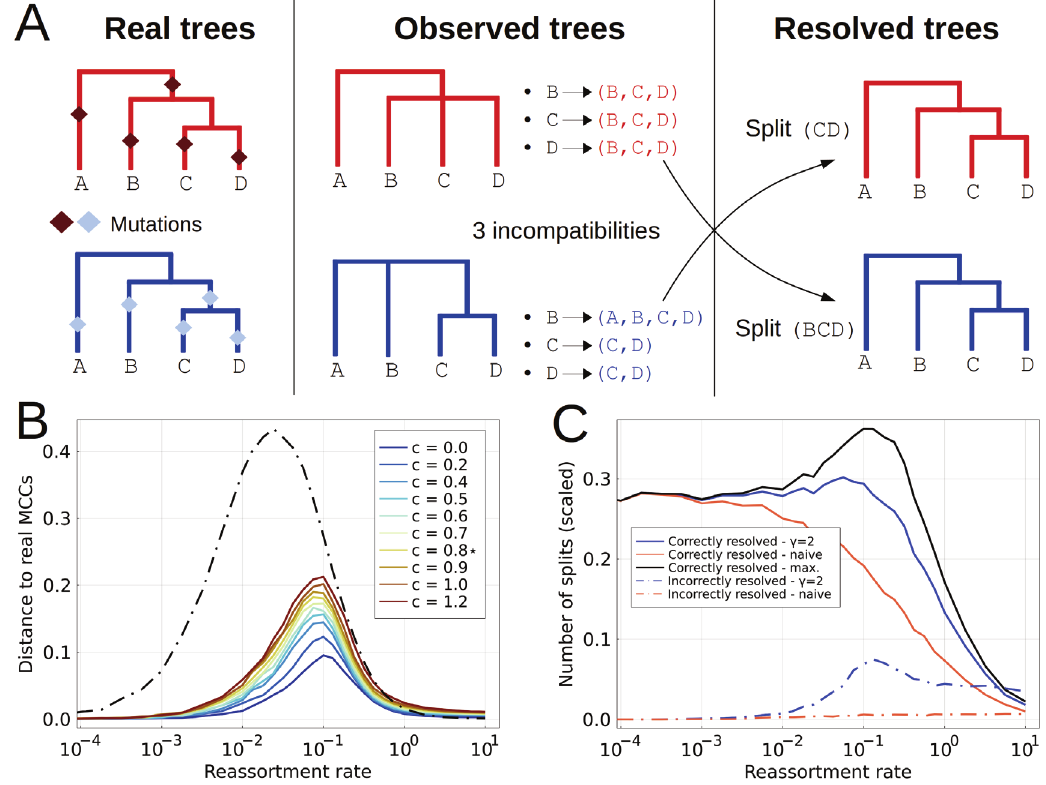
Fig 4. Effect of poorly resolved trees on the inference of MCCs. A : Pre-resolving trees before inferring MCCs. The approach is greedy: every split of one tree that is compatible with the other is introduced in the other. B : VI distance to real MCCs as a function of r ? for different tree resolutions c , using γ = 2. The dashed line corresponds to the naive method γ ! 1 . The quality of the inference decreases with c . c ? ’ 0.8 corresponds to levels found in A/H3N2 influenza trees with strains from the same season. C : Quality of the resolution of trees after having inferred MCCs. This combines splits introduced by the pre-resolution step, and splits known once the MCCs are inferred. The number of correctly inferred splits is shown, scaled by the number of splits that would be necessary to make the trees binary. The black line indicates the performance if the MCCs were exactly